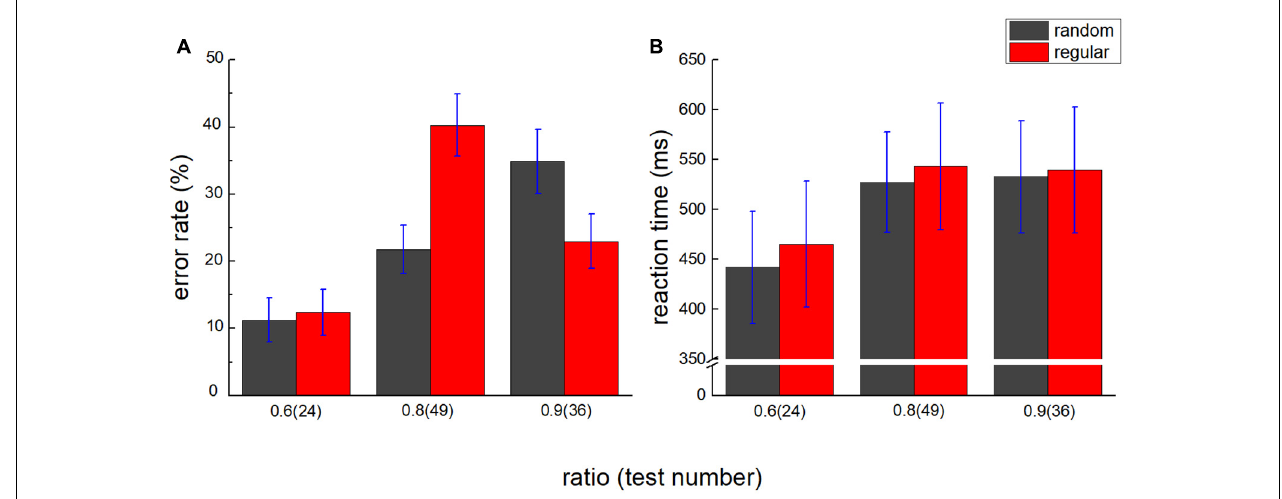
FIGURE 3 | Number distance effect on error rate and reaction time. (A) Error rate of test 24 (ratio = 0.6), 49 (ratio = 0.8), and 36 (ratio = 0.9) is plotted against the number ratio. Black bars denote the random group, and red bars stand for the regular group. (B) Reaction time is plotted against the number ratio. Number distance effect is suggested in both groups. Error bars denote 1